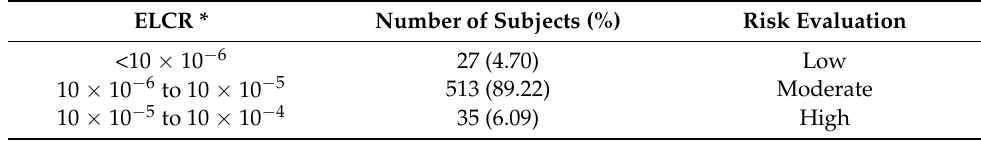
Table 6. ELCR in indoor slate